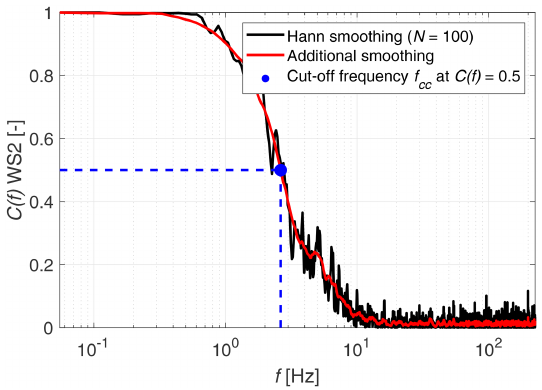
Figure 21. Coherence between WindScanner 2 and the hot-wire anemometer for a coefficient of variation of 12.9% (Case